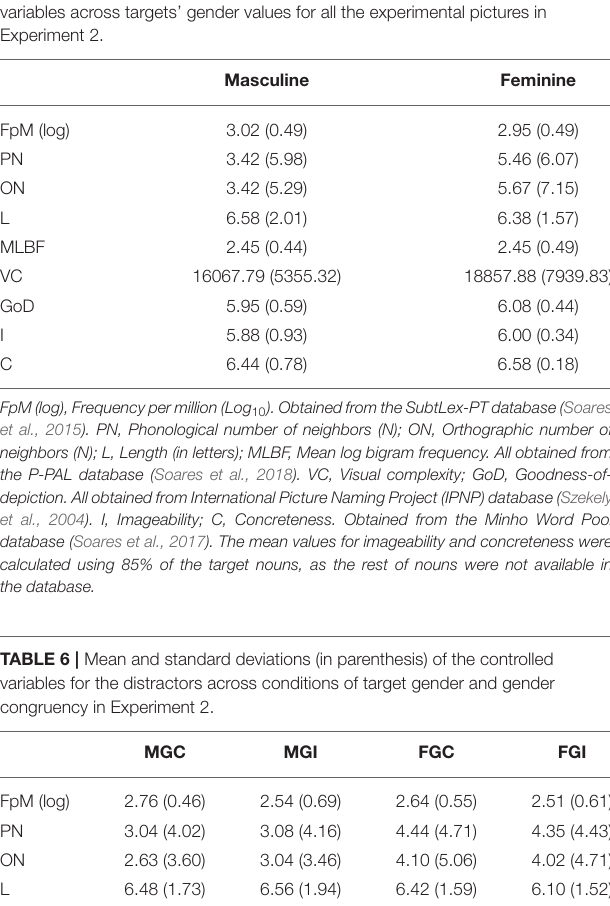
TABLE 7 | Mean reaction times and standard errors (SE) for each condition in Experiment 2.